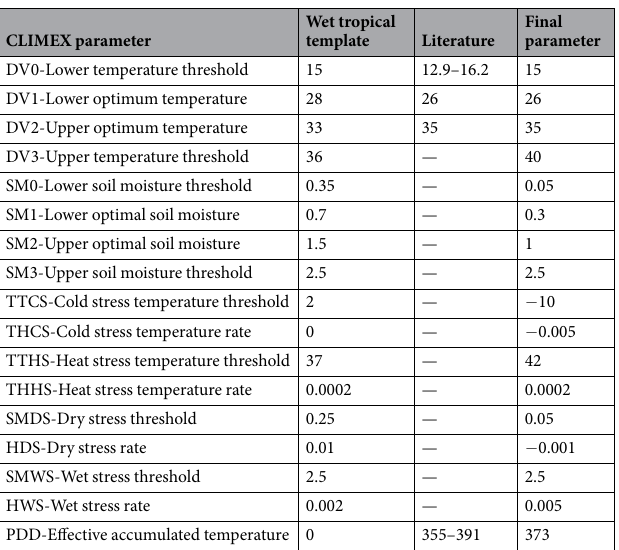
Table 1. CLIMEX parameter values for Euwallacea fornicates . The values in Wet Tropical Template came from CLIMEX, and the values in the middle column were from the